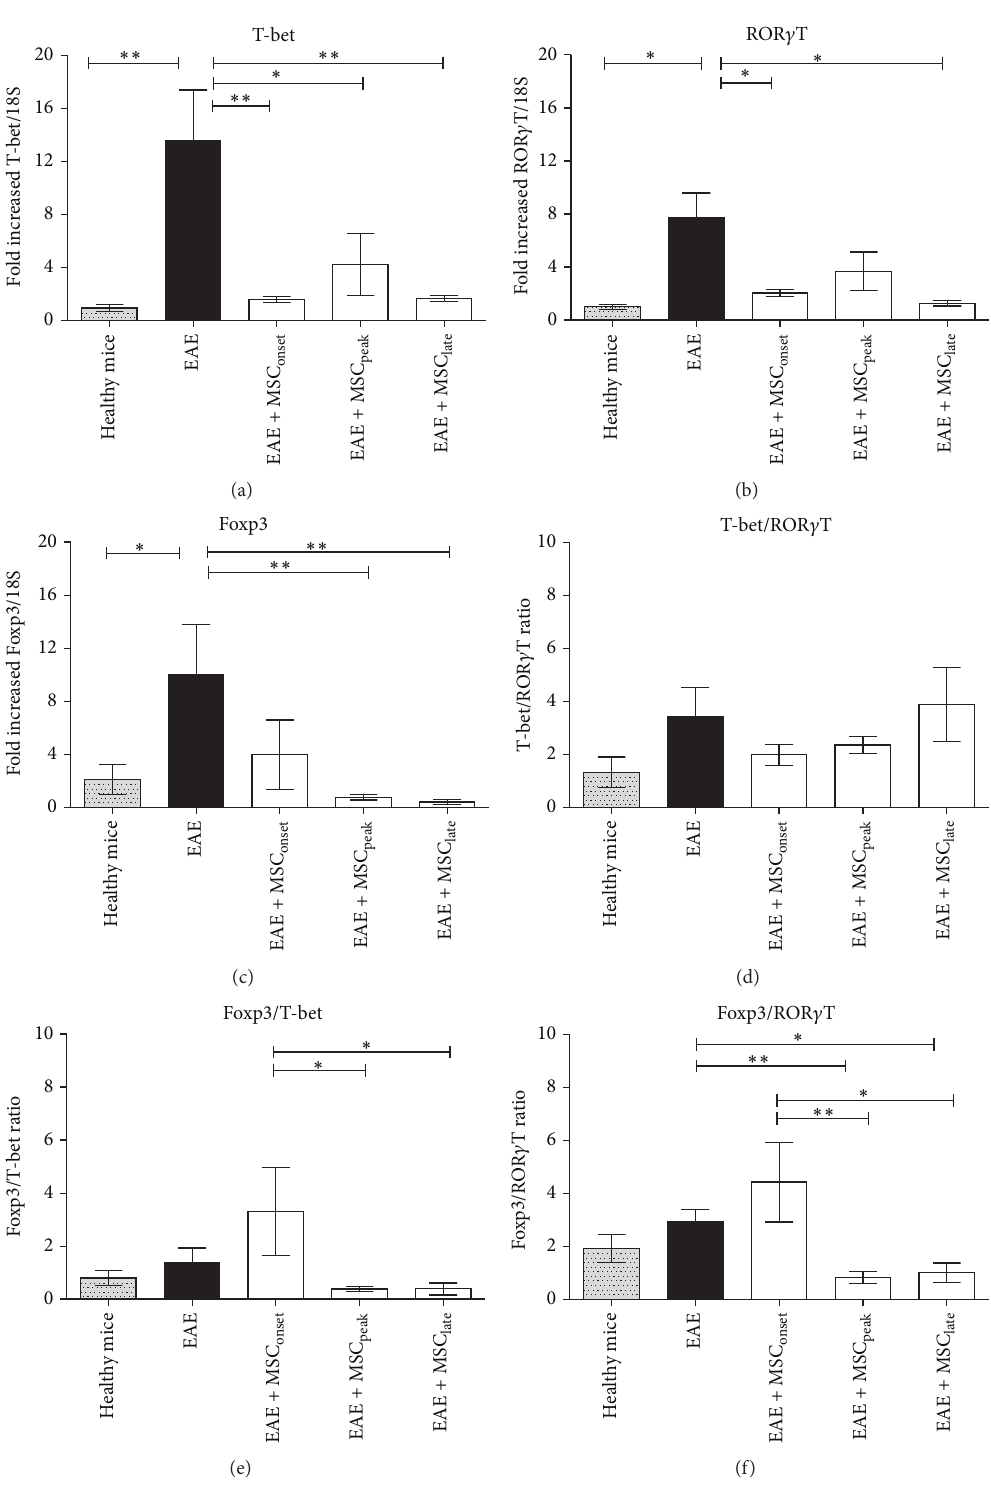
Figure 5: MSCs injections at different stages of EAE diminished brain T-bet, ROR 𝛾 T, and Foxp3 mRNA levels. Healthy C57BL/6, EAE mice, ), at the peak (EAE + MSC ), and at the time of EAE stabilization or EAE mice injected with MSCs (1 × 10 6 ) at the onset (EAE + MSC onset peak ) were sacrificed after 50 days of EAE progression. Total brain RNA was extracted (Trizol) and 2 𝜇 g of DNAse-treated RNA was (EAE + MSC late retrotranscribed as described in Methods. Relative mRNA levels of bona fide transcriptions factors associated with CD4+ T helper subtypes Th1 ( T-bet , (a)), Th17 ( ROR 𝛾 T , (b)), and Treg ( Foxp3 , (c)) were determined by RT-qPCR using the 2 −ΔΔ Ct method. Individual ratios, (d) T- bet/ROR 𝛾 T, (e) Foxp3/T-bet, and (f) Foxp3/ROR 𝛾 T were also calculated. Bars in the plots represent the mean ± SEM. Statistical differences were calculated using Mann-Whitney test ( ∗ 𝑃 < 0.05 , ∗∗ 𝑃 < 0.005 ), 𝑛 = 7